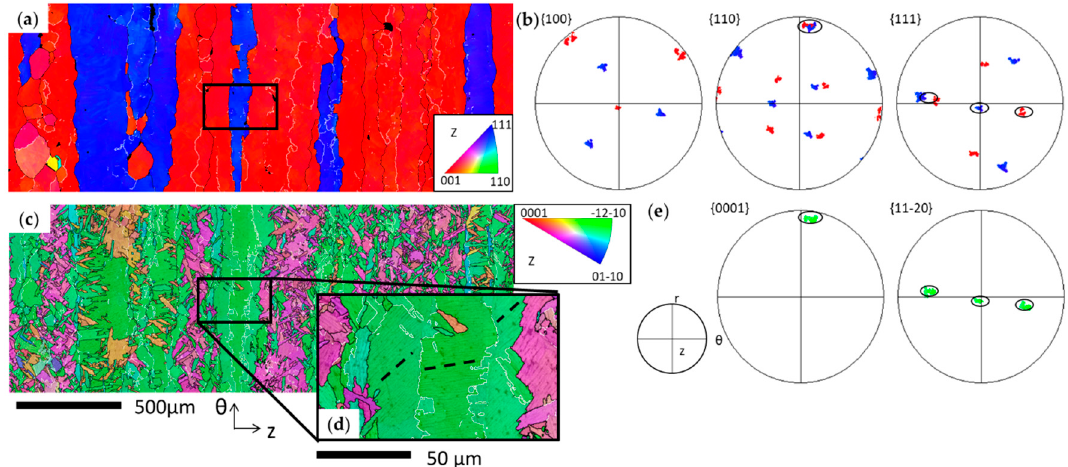
Figure 3. Local microtexture in the disk: ( a ) IPF//z EBSD maps for the reconstructed β phase and ( b ) orientations of the three β parents of the feather microstructure as PFs (z in the center) ( c ) IPF//z EBSD maps for the measured α phase; ( d ) Close-up view of the three extended colonies, the overlap of the Kikuchi Pattern Quality map reveals the morphological orientations of the colonies (underlined with the black dashed lines); ( e ) α orientations of the feather-like colonies.